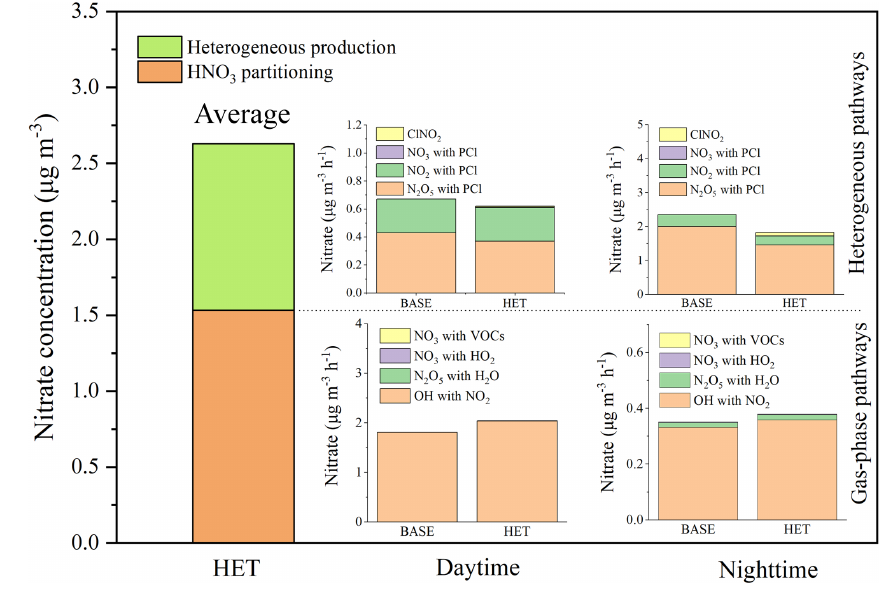
Figure 4. Contributions of different homogeneous and heterogeneous pathways to nitrate